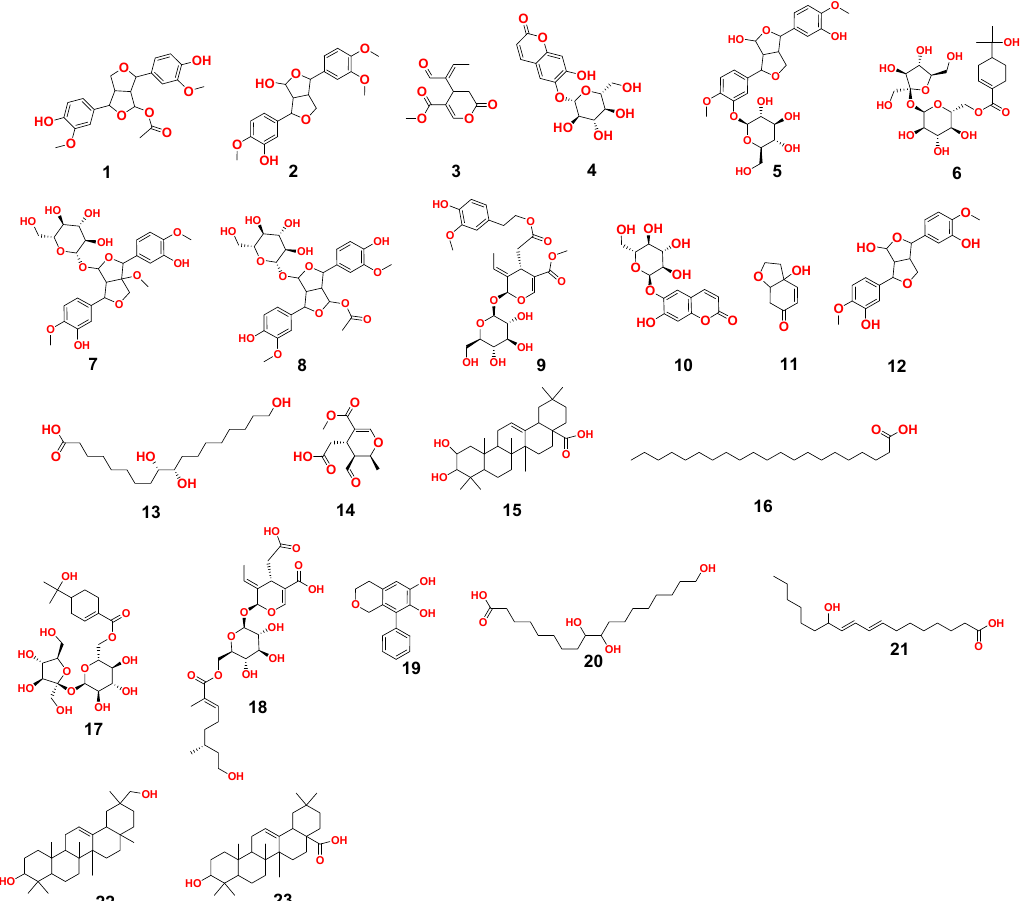
Figure 3. LC-HRESIMS chromatogram of the dereplicated metabolites of OEA (negative mode).